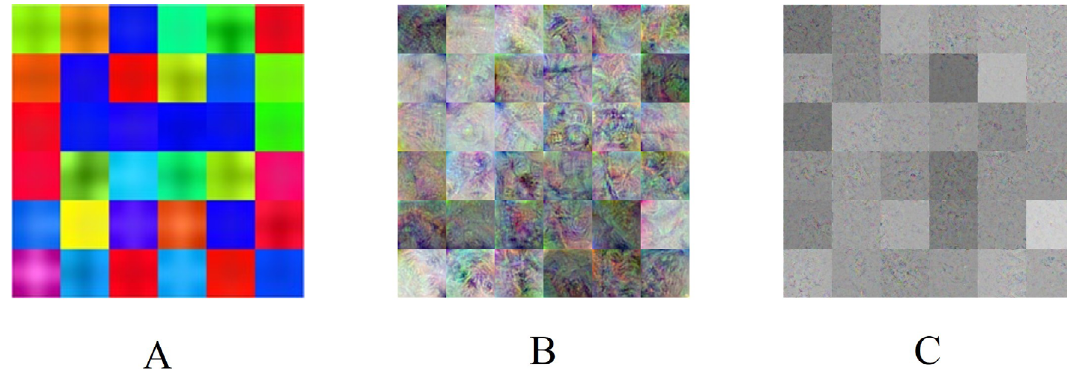
Figure 4. NASNet-Large features. A. Convolution layer “stem_conv1” (2nd layer), B. average pooling layer “normal_left3_8” (617th layer), and C. global average pooling layer “global_average_pooling2d_2” (1240th